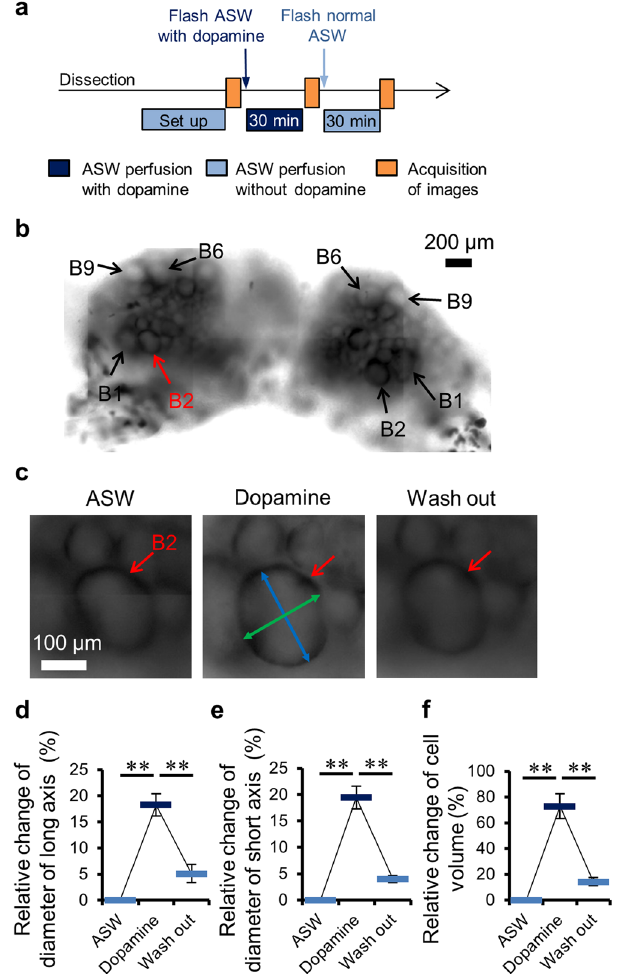
Figure 1. Dopamine stimulation induced neural cell swelling. ( a ) Time course of microscopy imaging. ( b ) Representative microscopy image of the entire buccal ganglia. ( c ) Representative microscopy images of somas of neuron B2 (red arrows) in ASW, after dopamine stimulation, and after washout. A blue arrow head shows the cell’s long axis and a green shows the short axis. The average relative change of the long axis ( d ), short axis ( e ), and volume ( f ) of neuron bodies for neurons B1, B2, B6, and B9 of each ganglion. These values were averaged over 26 neurons (7 B1 neurons, 7 B2 neurons, 6 B6 neurons, and 6 B9 neurons) in 4 Aplysia (each ganglion contains two neurons of each type). The images of cells with ambiguous contours were discarded. ** p < 0.01 (Tukey-Kramer’s test). Bars plots exhibited mean ±